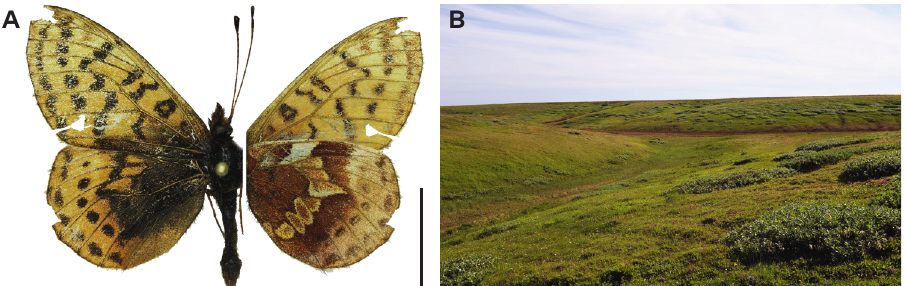
Figure 2. Boloria frigga on Kolguev Island: A General view of the specimen . Scale bar = 10 mm. (Photo: Elizaveta A. Spitsyna); B Habitat (moss-herb tundra) of this species on Kolguev Island (Photo: Grigory S.